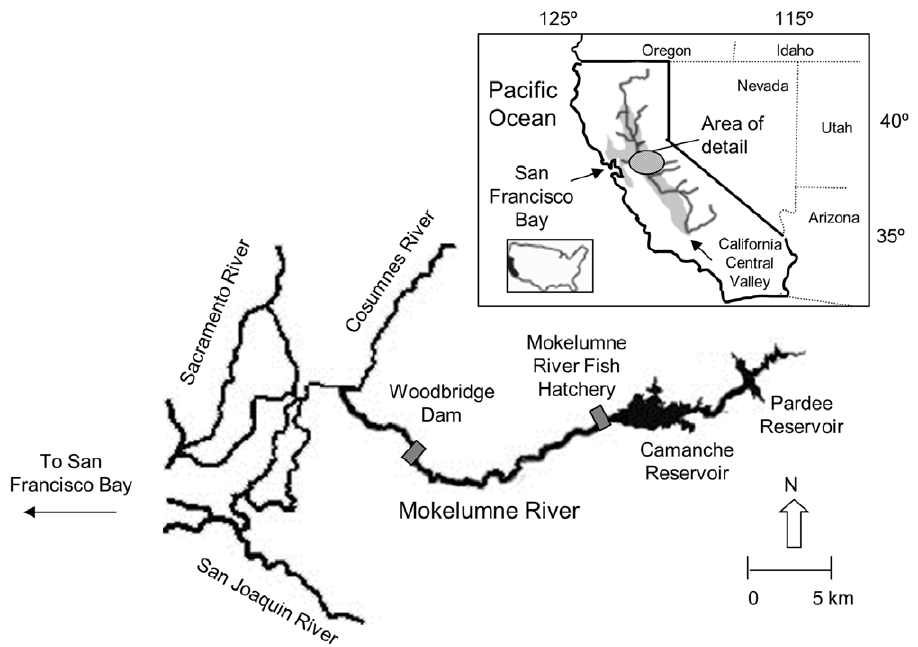
Figure 2. Map of study region. The Mokelumne River and Mokelumne River Fish Hatchery in relation to the western United States, and the Sacramento-San Joaquin river system (shaded region) in California’s Central Valley (insert). The in-river spawning habitat on the Mokelumne River consists of the area between its confluence with the Cosumnes River and upstream to the Camanche Dam ( , 16 km).